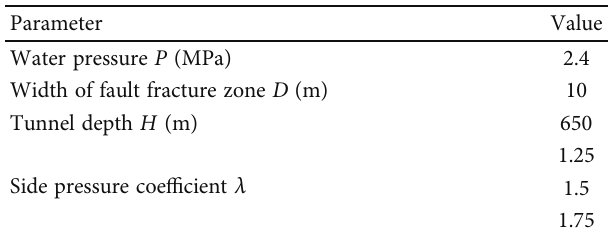
Figure 4: Changes in horizontal stress at the right arch waist on the right side and vertical stress at the top of the vault under di ff erent water pressures. Table 4: Calculation parameters for side pressure coe ffi cient